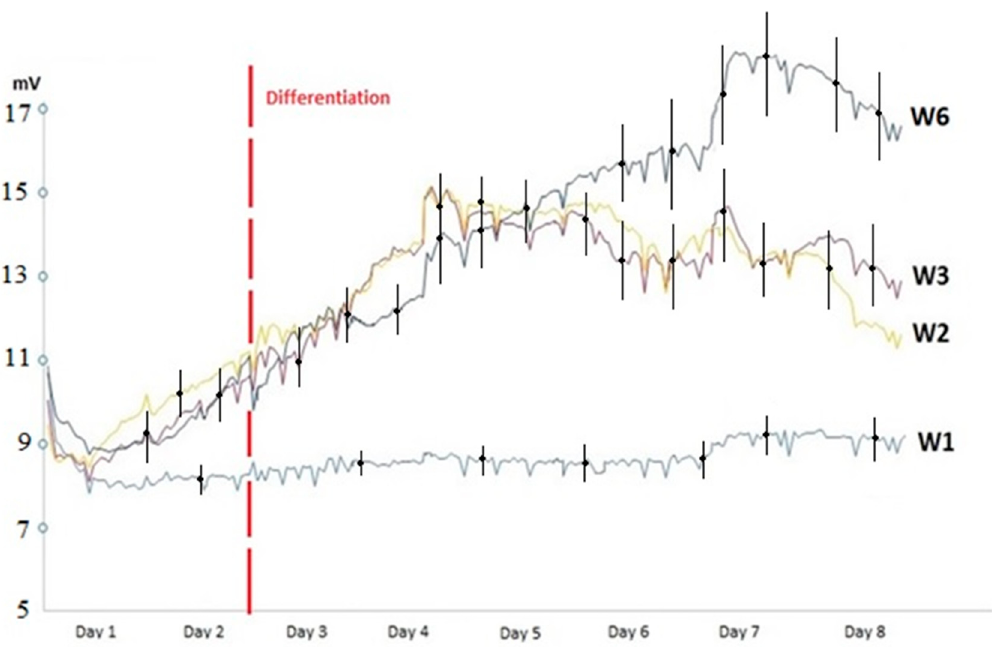
Figure 4. Obtained amplitude signals. Amplitude signals monitored for stem cells without differentiation (W2, W3) and with differentiation (W6). The cell culture medium was also measured (W1). It can be observed that after an initial transient regime, all signals corresponding to cell cultures started to rise, corresponding to cellular growth. After the differentiation medium was used (day 2) and after a transitory stop in the measured amplitude corresponding to a decrease in cell proliferation (with a mean delay of 0.8 days; and standard deviation of 0.1 days), stem cells following the differentiation process (W6) showed a greater increase in the monitored amplitude in comparison with the undifferentiated cell cultures (W2, W3).